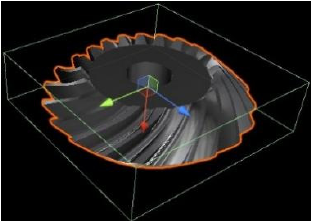
Figure 2. Cube bounding box and its datum